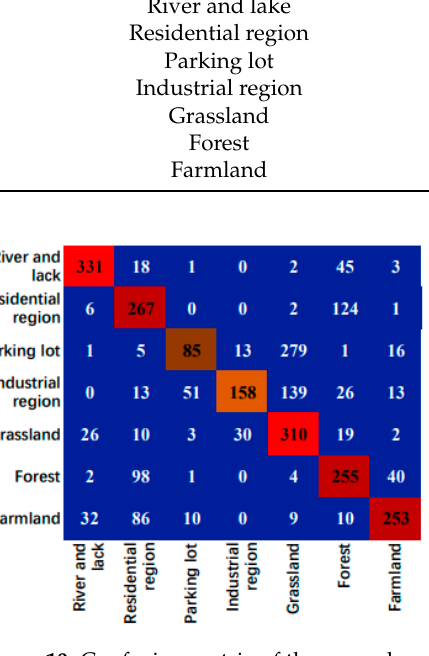
Table 2. Accuracy of various scenes in cross-domain scene classification of the UCM and RSSCN7 datasets of SGNAS. Table 1. Overall accuracy and inference time of cross-domain scene classification of different models on UCM → RSSCN7.